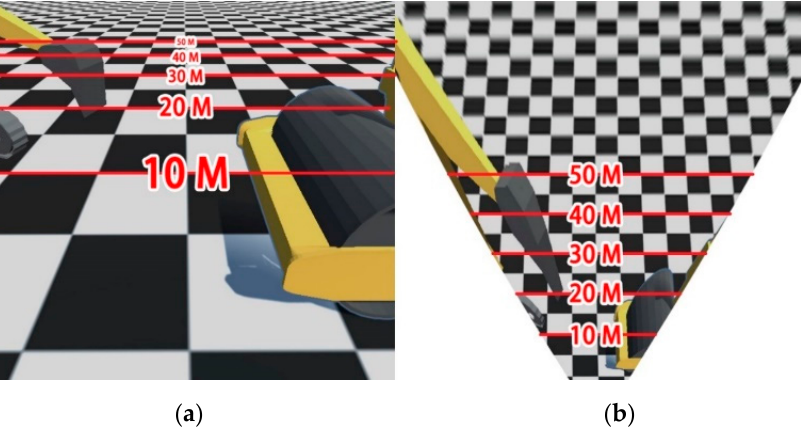
Figure 6. Mapping the object in images to the actual location ( a ) before and ( b ) after projective transformation.